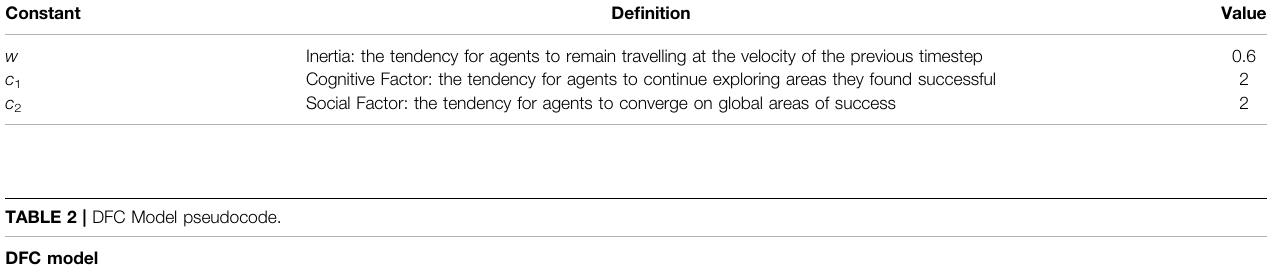
TABLE 2 | DFC Model pseudocode.